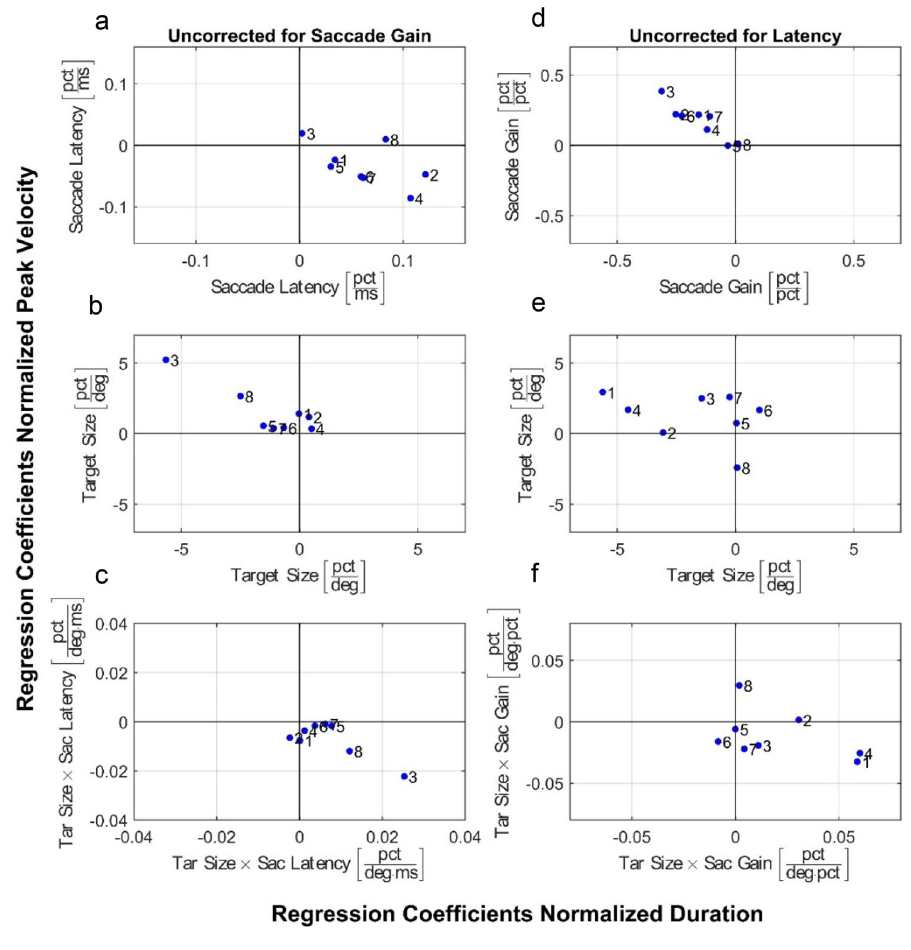
Figure 5. Normalized main sequence regression. Scatter plots of the regression coefficients which quantify how the normalized duration (horizontal axis) and the normalized peak velocity (vertical axis) depend either on target size and saccade latency ( a – c ) or on target size and saccade gain ( d – f ). Each numbered dot in the plots represents a single subject. ( a – c ) Regression coefficients when saccade latency, target size, and the interaction of the two are taken into account, and saccade gain is not. (as in Fig. 4a,b) The applied regression equations were (Wilkinson Notation): Normalized saccade duration ~ Target size + Saccade latency + Target size × Saccade latency. Normalized saccade peak velocity ~ Target size + Saccade latency + Target size × Saccade latency. ( d – f ) Regression results considering only saccade gain, target size, and the interaction of the two, but